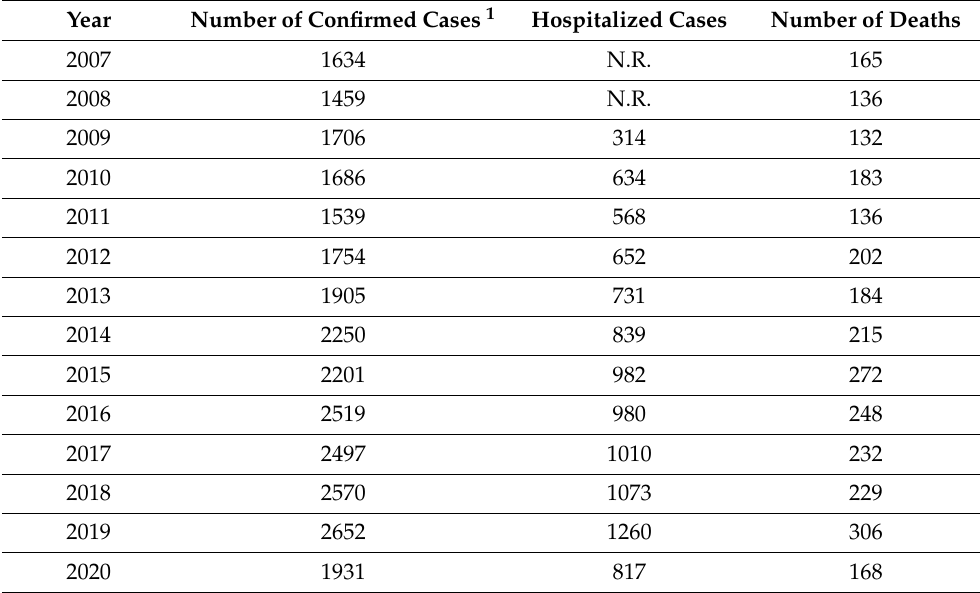
Table 1. Number confirmed cases, hospitalized cases and number of death of Listeriosis oubreaks in EU/EEA (31 States) from 2007 to 2020.